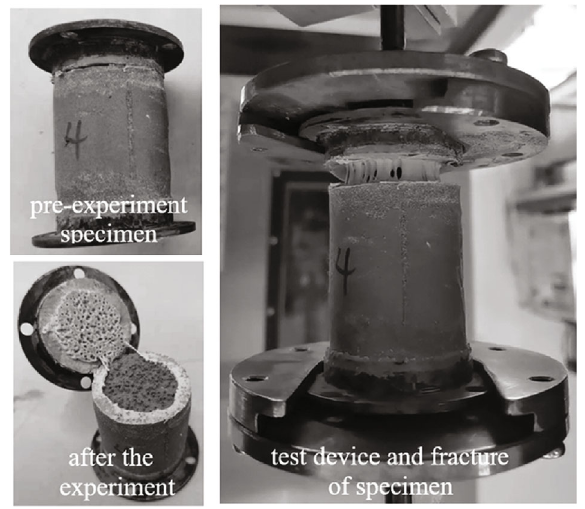
Figure 4: The insulation/cladding interface debonded crack specimen and tensile test